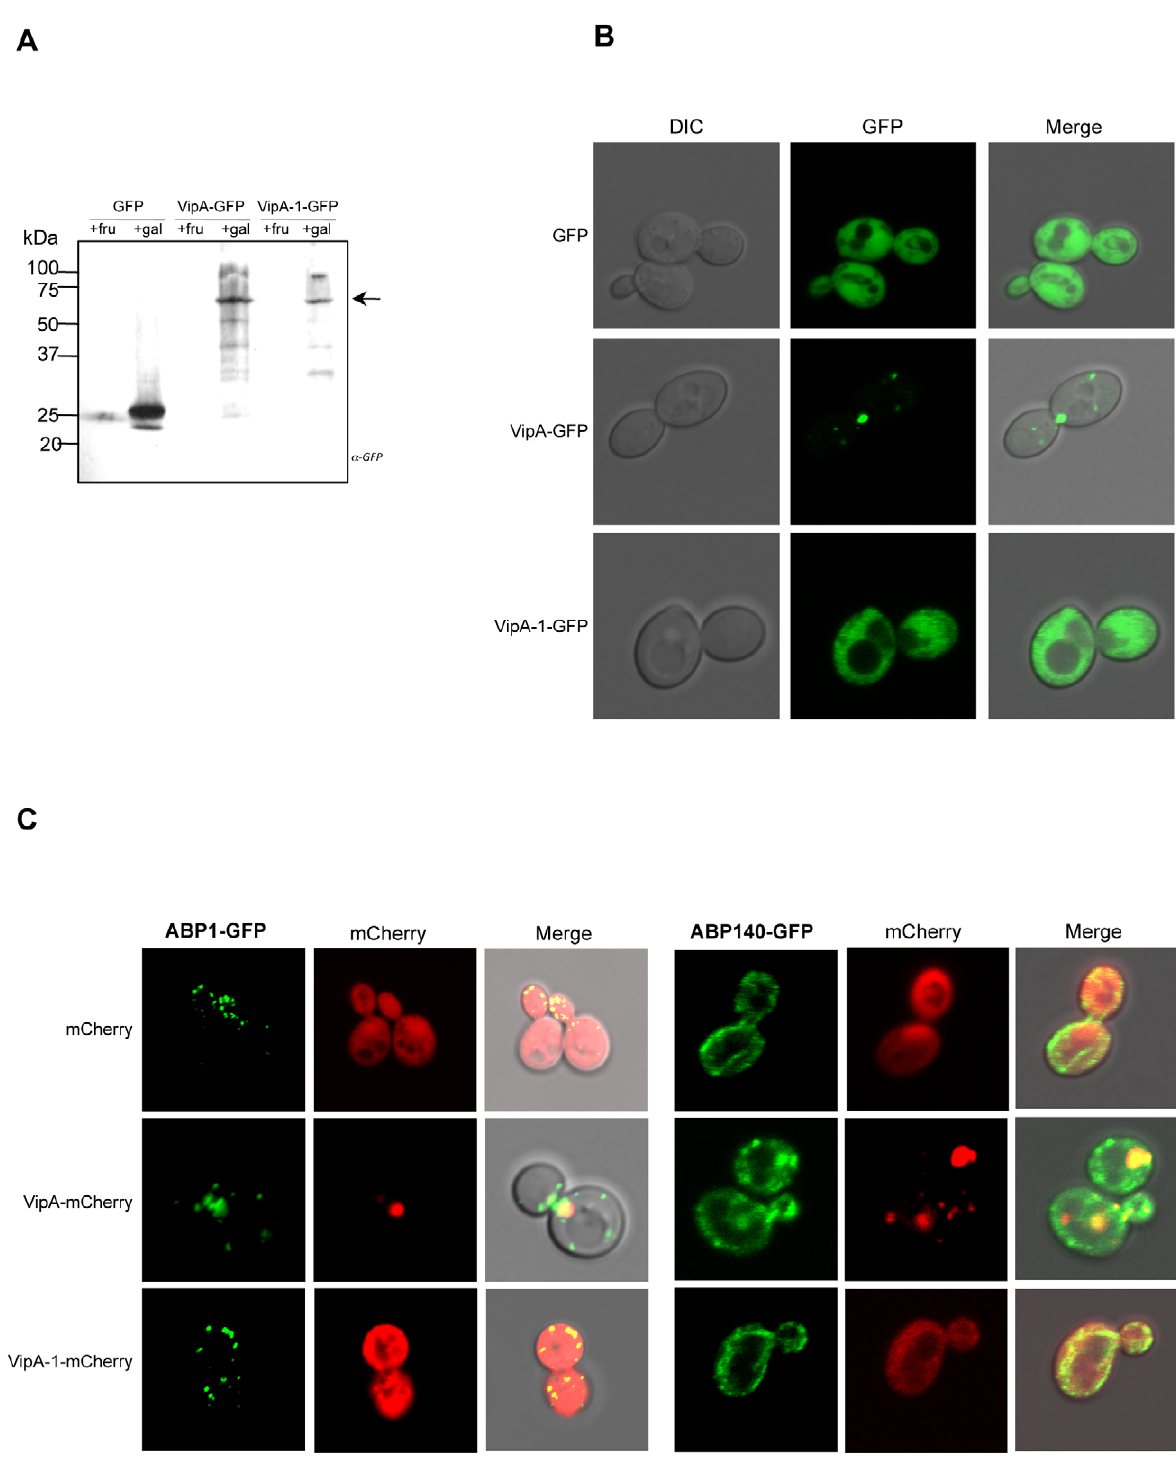
Figure 4. Localization of VipA-GFP in S.cerevisiae . A. Yeast strains producing GFP, VipA-GFP or VipA-1-GFP (respectively strains SCIF00, SCIF01 and SCIF02) were grown in medium with fructose or galactose to an OD 600 , 0.5. Equivalent amounts of cell lysates were run on SDS-PAGE and analysed by Western-blot using an anti-GFP polyclonal antibody [57]. The arrow points to the bands corresponding to VipA-GFP or VipA-1-GFP fusion proteins. B. The same strains grown in galactose were viewed using Laser Scanning Confocal microscopy and representative images are shown (left). C. Colocalization of VipA-mCherry and actin structures in yeast. Yeast strains producing mCherry, VipA-mCherry or VipA-1-mCherry and Abp1-GFP (left) or Abp140-GFP (right; see Table S1) were grown and visualized as above.